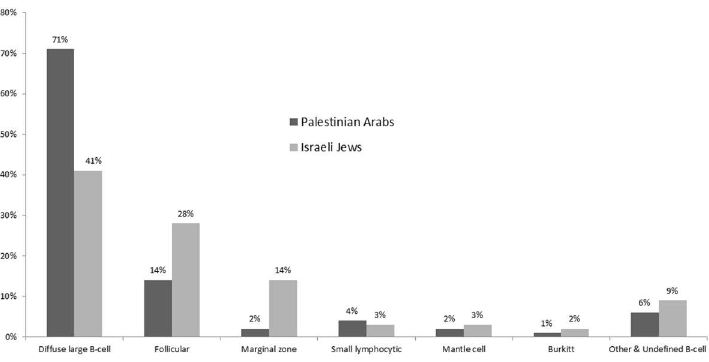
Fig 3. B-cell non-Hodgkin lymphoma (B-NHL) subtype distribution by